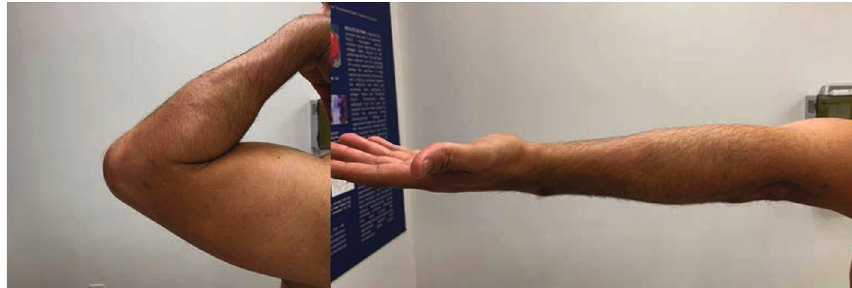
Figure 2: 6-month postoperative range of motion.